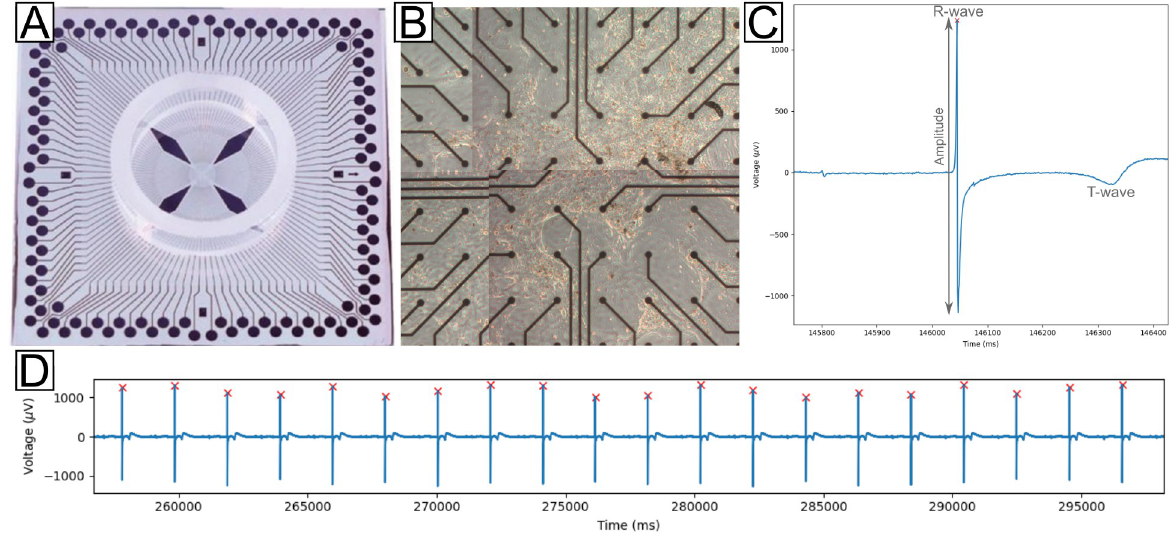
Fig 1. Representative MEA device, culture and field potential signals. A) 120 electrode MEA with TiN electrodes. B) Cardiomyocyte culture on a 120 electrode MEA. C) Field potential showing three beats. Beat amplitude is indicated with a vertical arrow line in red. D) Extended view of field potentials for one electrode across a 45 second interval. In both C and D, R-wave-like field potential peaks, as detected by the findpeaks algorithm, are marked with a red X.